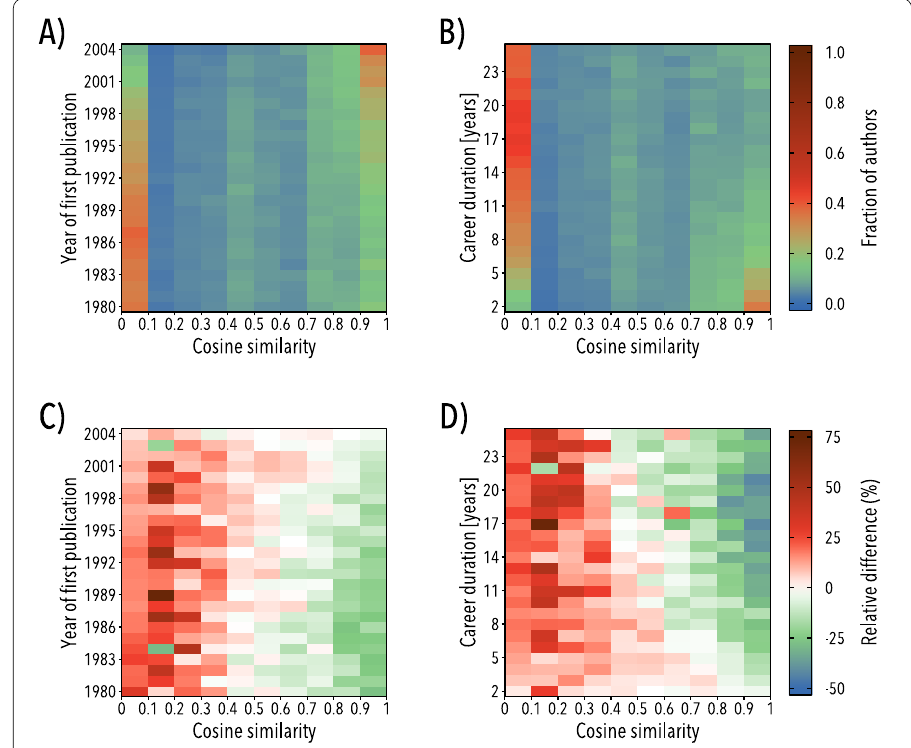
Figure 3 Cosine similarity distribution of authors’ interest between the first and last years of their careers measured using the second level of the classification scheme. (panel ( A )) Cosine similarity distribution as a function of when they started their careers. (panel ( B )) Cosine similarity distribution as a function of the duration of their careers. In both cases there is a clear tendency towards exploration. (panels ( C )–( D )) relative change between the data and the null model, measured as the relative error between the two, as a function of the first year of publication (panel ( C )) and the career duration (panel ( D